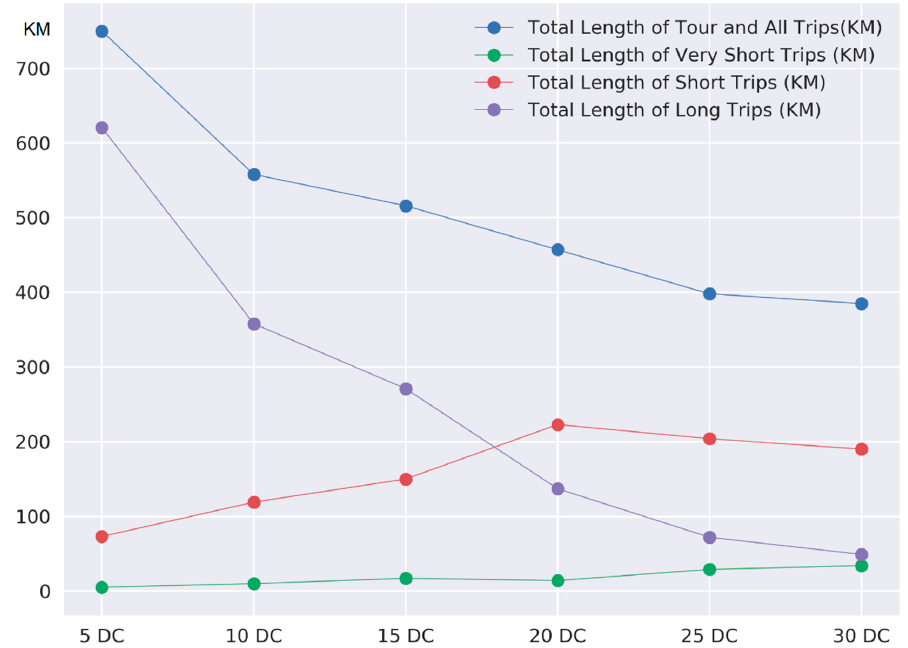
Figure 4. Total length of trips.